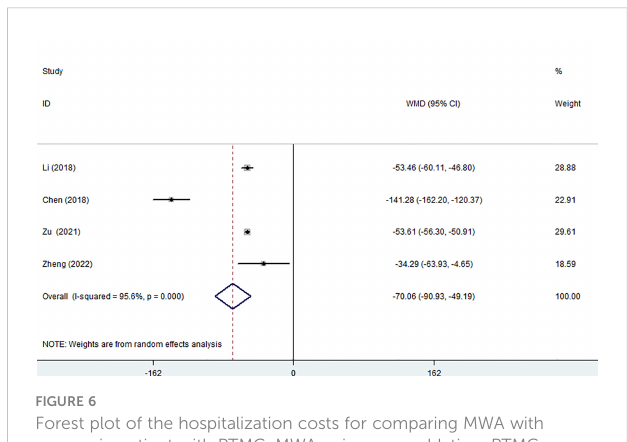
FIGURE 6 Forest plot of the hospitalization costs for comparing MWA with surgery in patient with PTMC. MWA, microwave ablation, PTMC, papillary thyroid